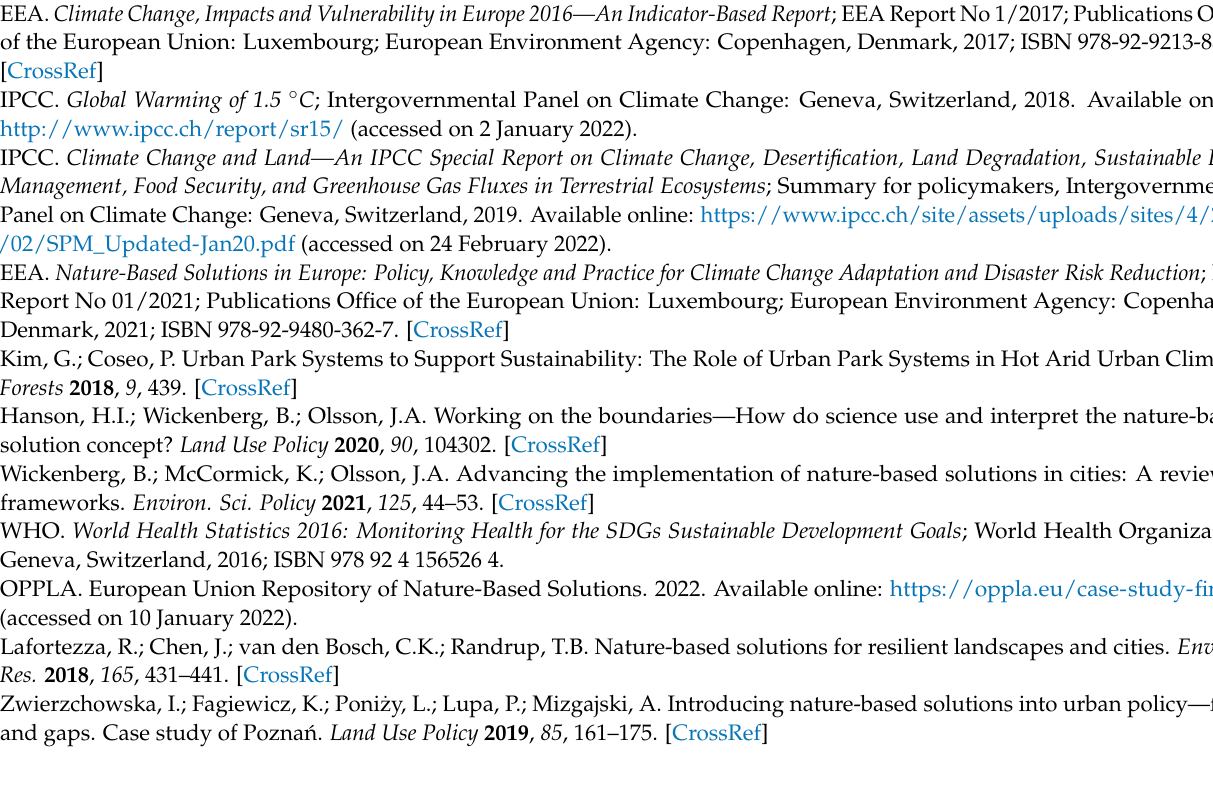
Statistics: Madrid meteorological stations; Figure S1. Annual mean temperature, wind speed (10 m) and PBL height relative changes (100 × (Future − Baseline) / Baseline); Figure S2. Seasonal mean variation (Future − Baseline) sensible heat flux (W m − 2 ) at the surface in summer (a) and winter (b). Seasonal mean variation (Future − Baseline) latent heat flux at the surface in summer (c) and winter (d); Figure S3. Seasonal mean variation (Future − Baseline) of solar radiation absorbed at ground in winter (a) and summer (b); Figure S4. Detailed topographic map of the study area; Figure S5. Seasonal mean variation (Future − Baseline) of friction velocity ( ∆ USTAR) and wind speed in summer (a) and winter (b). Seasonal mean variation (Future − Baseline) wind direction in summer (c) and winter (d); Figure S6. NO 2 and O 3 relative changes (100 × (Future − Baseline) / Baseline); Figure S7. PM 10 and PM 2.5 relative changes (100 × (Future − Baseline) /